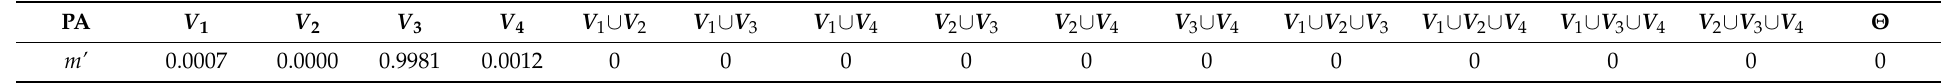
Table 18. The result of second-level fusion for an image of a transverse crack based on OAO